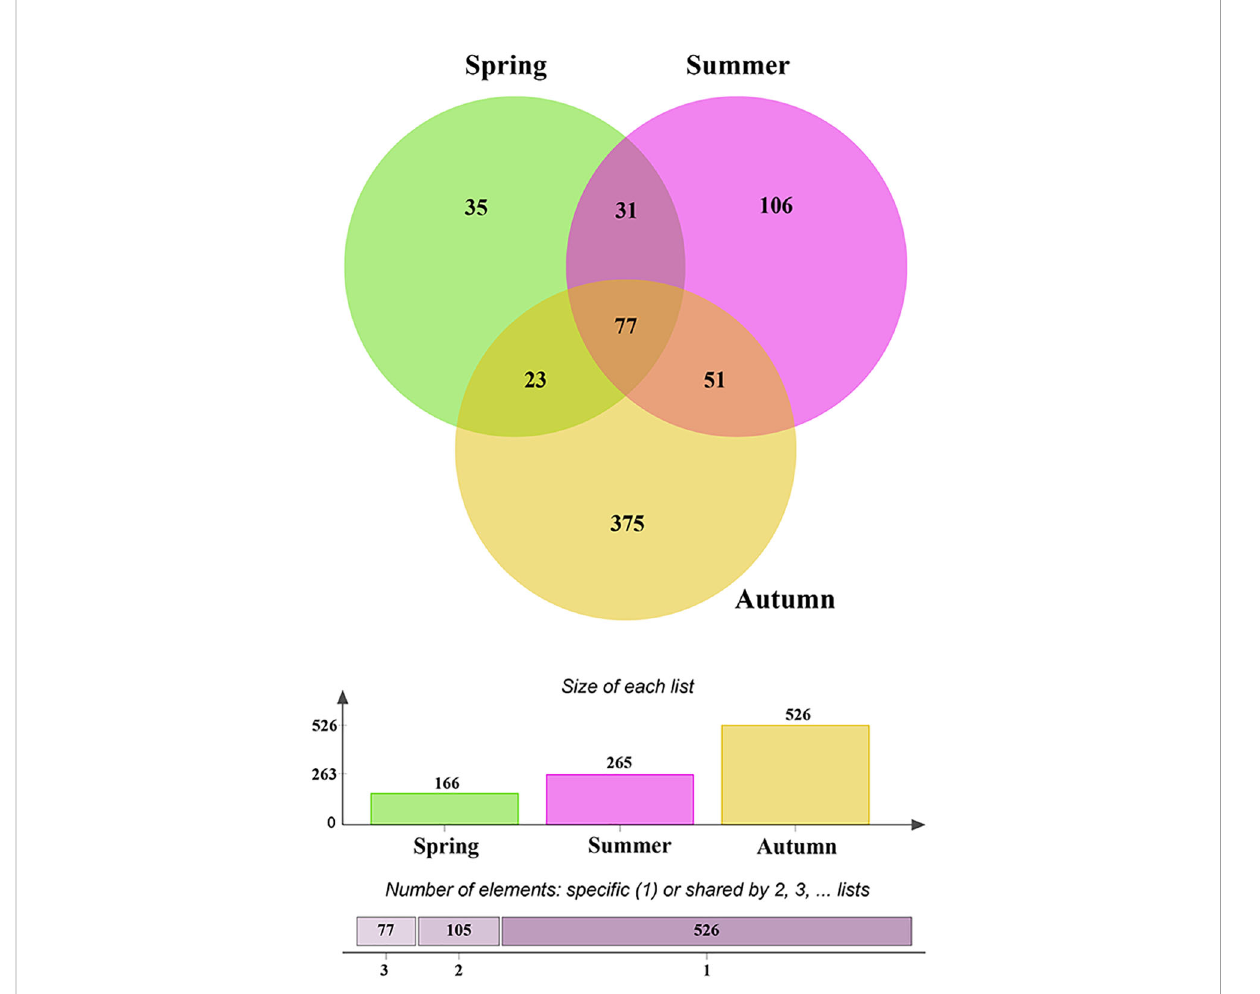
FIGURE 2 Venn diagram showing the shared and exclusive operational taxonomic units (OTUs) among